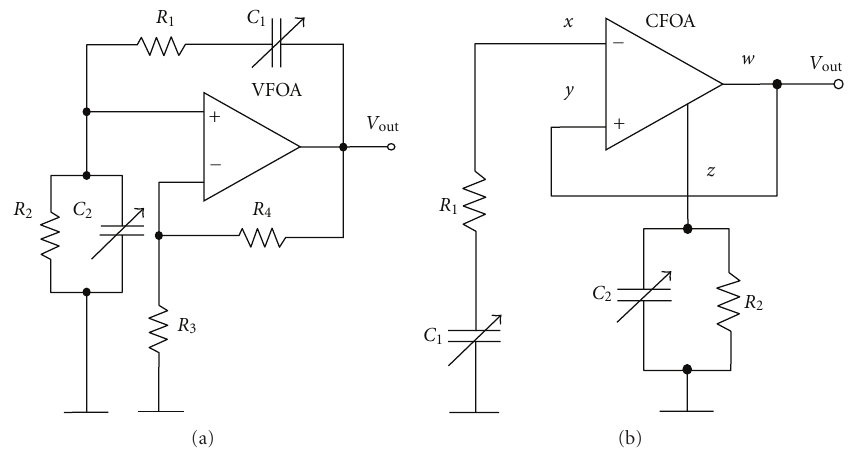
Figure 3: Oscillation systems circuits: (a) with usual amplifier VFOA; (b) with CFOA.